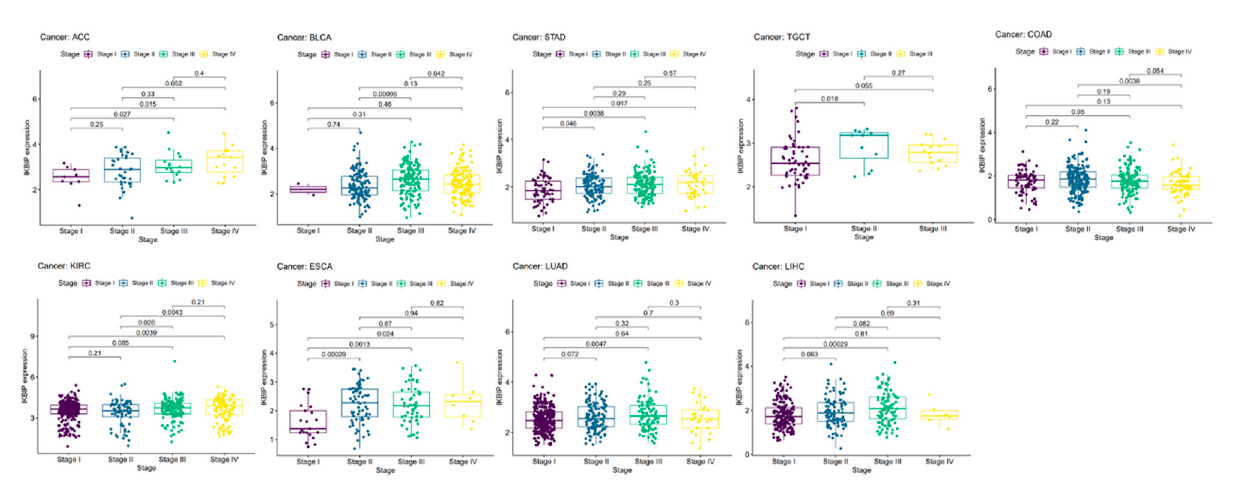
FIGURE 4 IKBIP ’ s prognostic signi fi cance in many malignancies. Cancer stage and IKBIP transcript levels are